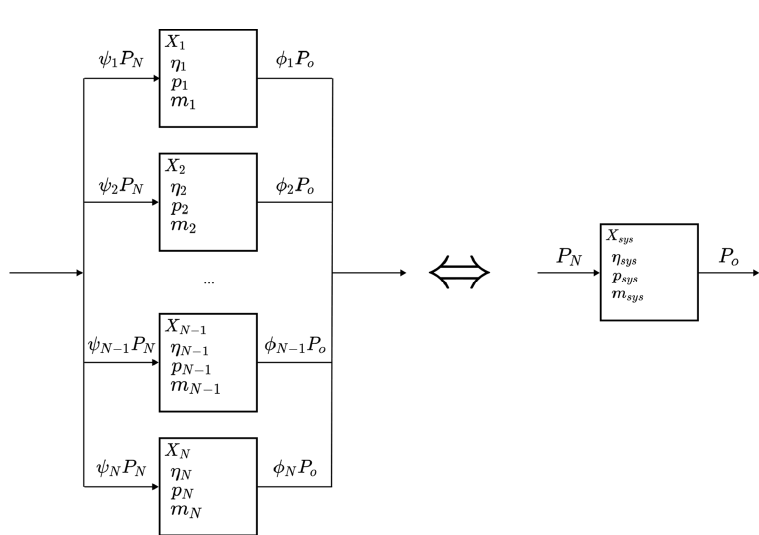
Figure 5. Parallel connection.